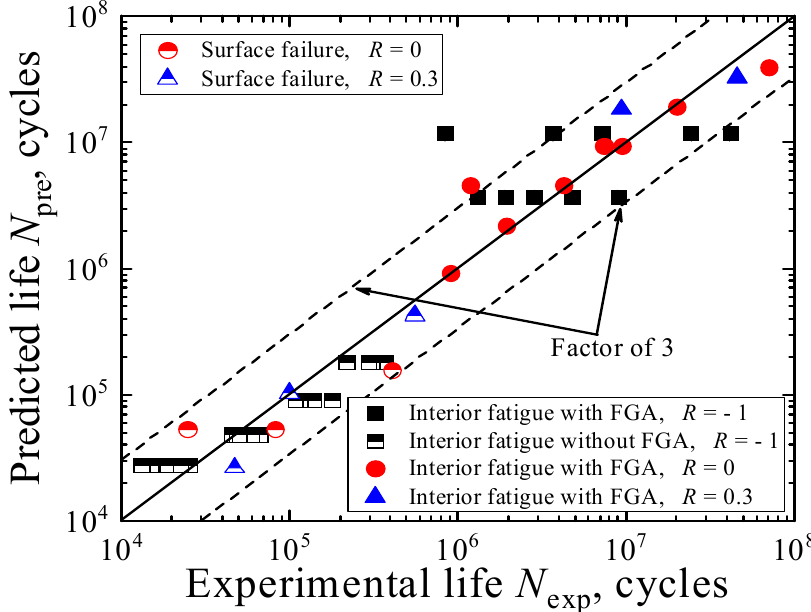
Figure 10. Comparison of predicted life and experimental life after model modification.